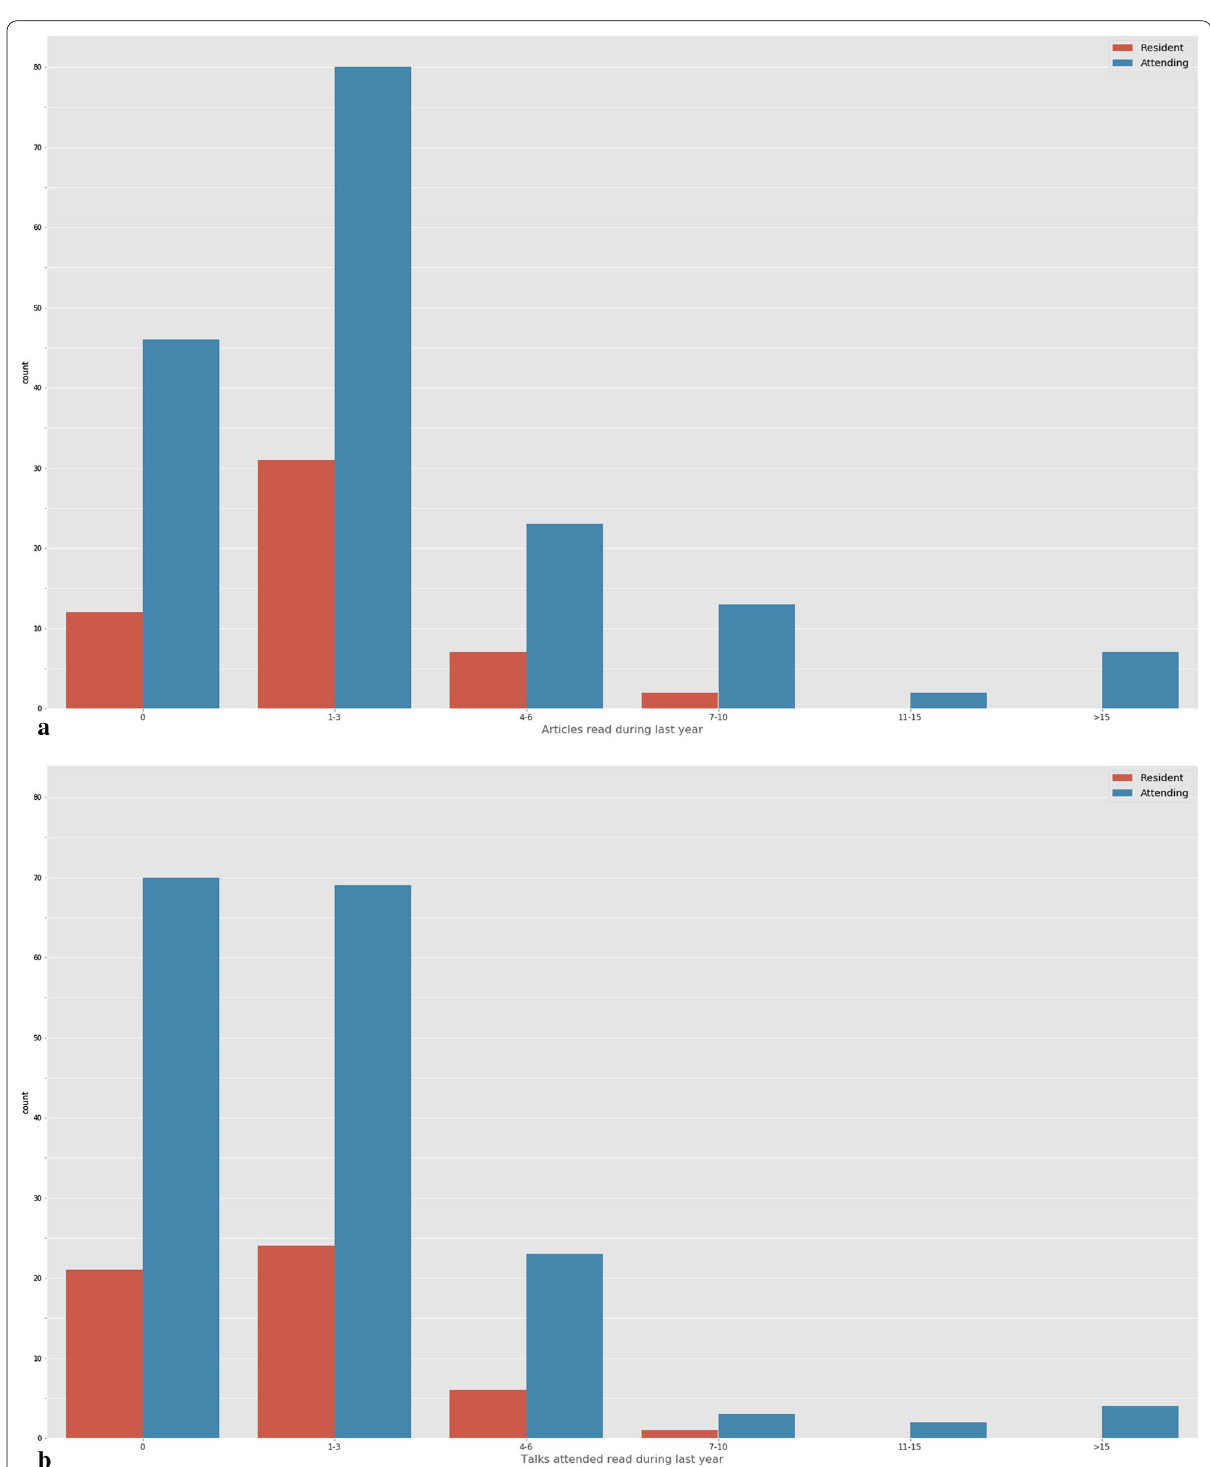
Fig. 3 Articles read ( a ) and lectures attended ( b ) during the year prior to the survey. Responses are divided into residents (red) and attending physicians